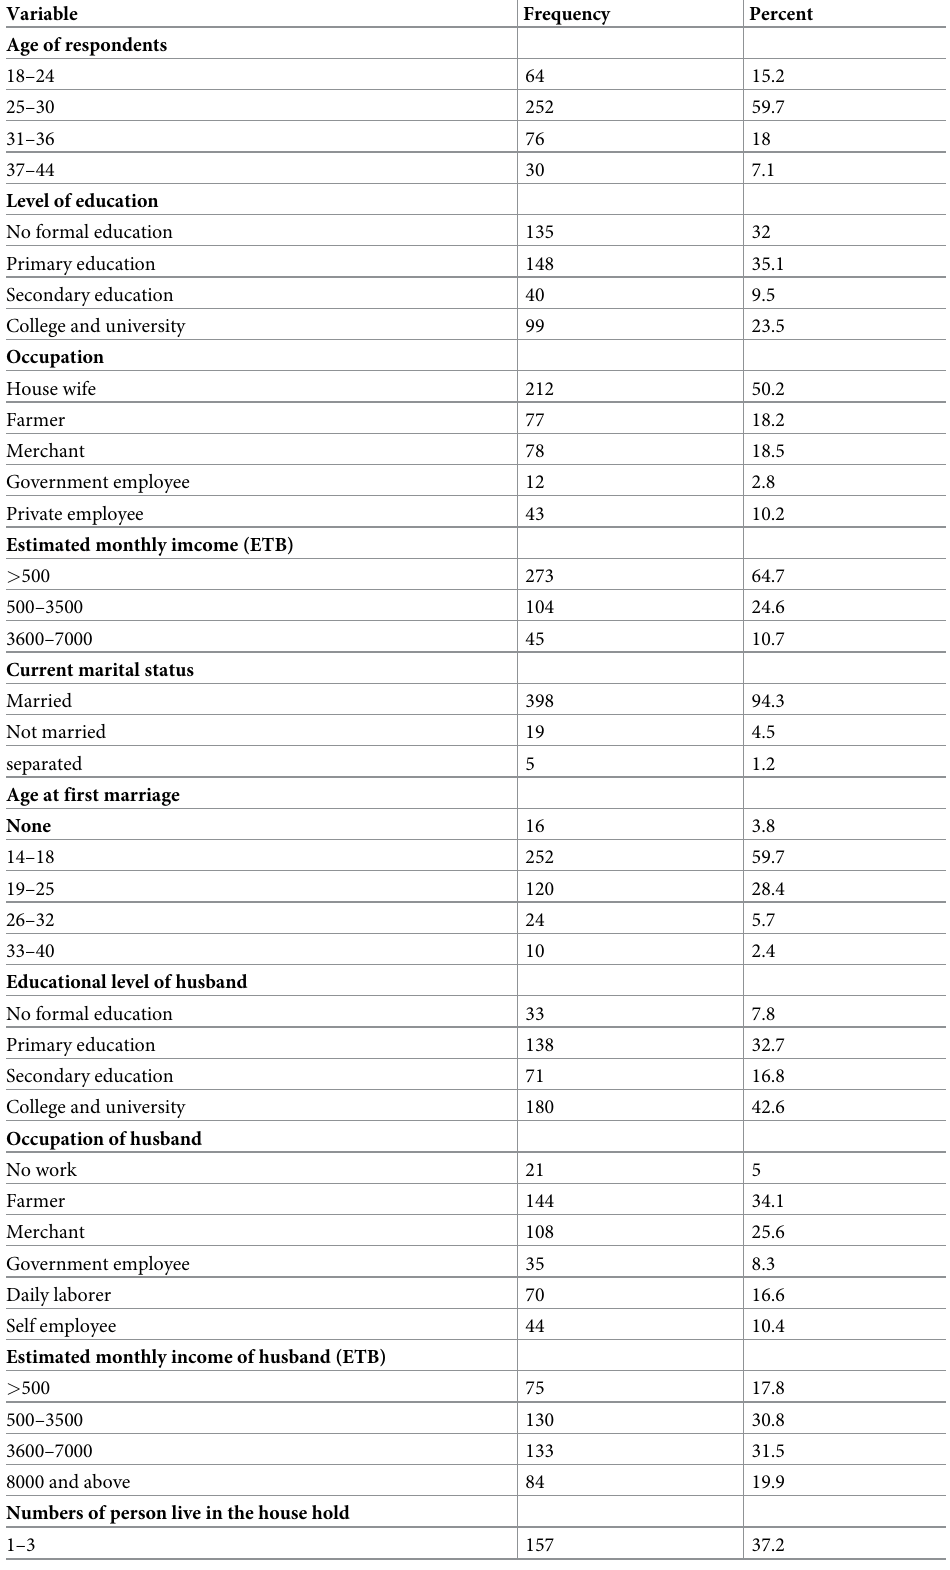
Table 1. Socio-demographic characteristics of women attending ANC follow up in Yirgalem general Hospital, Sidama Zone, Ethiopia; 2019 (n =